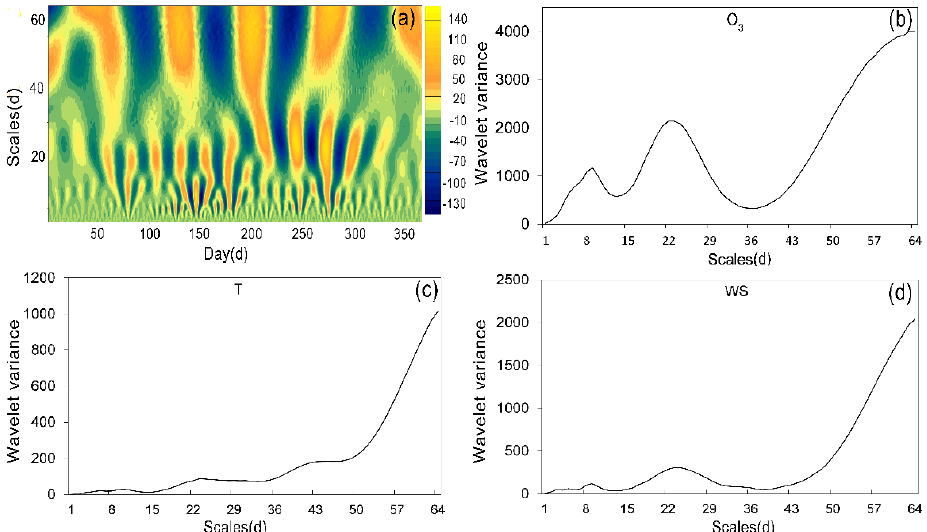
Figure 10. Real-part contours of wavelet coefficients ( a ), wavelet coefficient squared figure of O 3 ( b ), wavelet coefficient squared figure of T ( c ), and wavelet coefficient squared figure of WS ( d ).